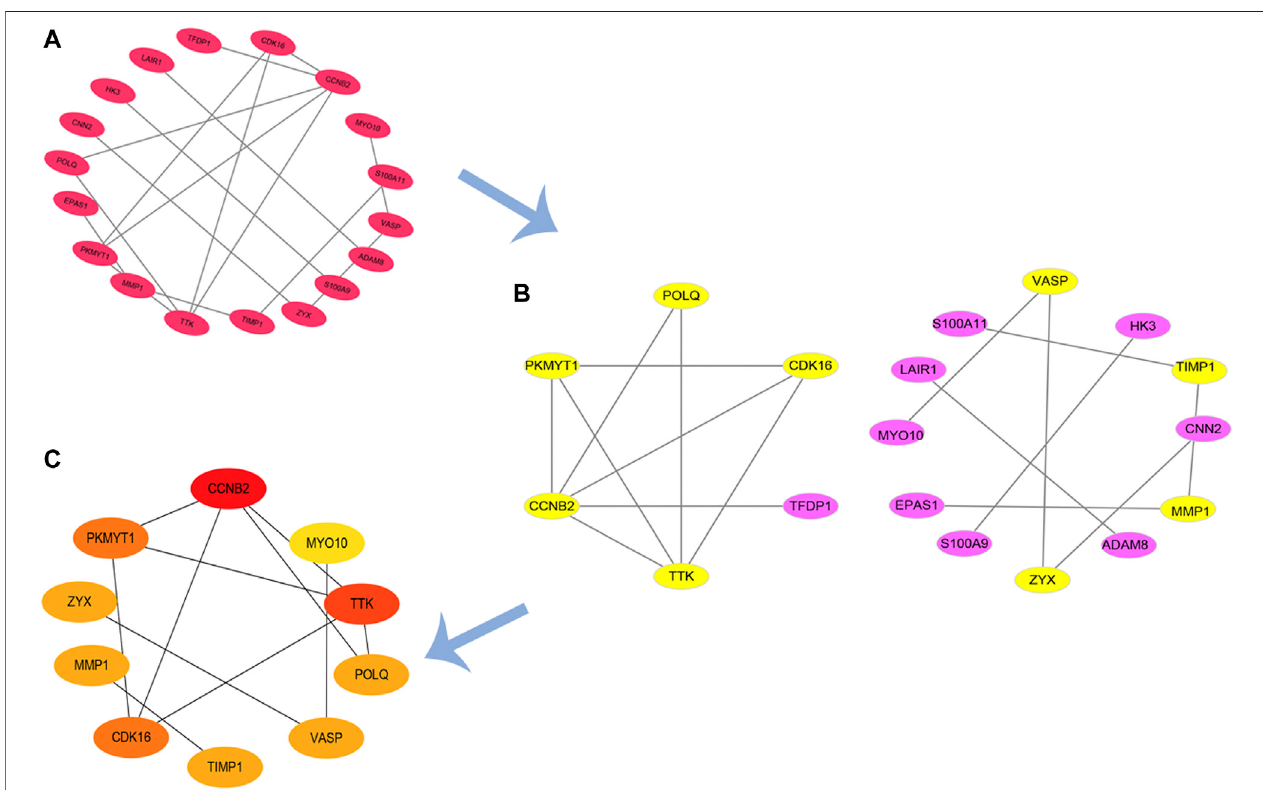
FIGURE 5 | PPI network of upregulated DEGs and hub genes. (A,B) PPI network of up-regulation DEGs; (C) identi fi ed hub genes by CytoHubba.